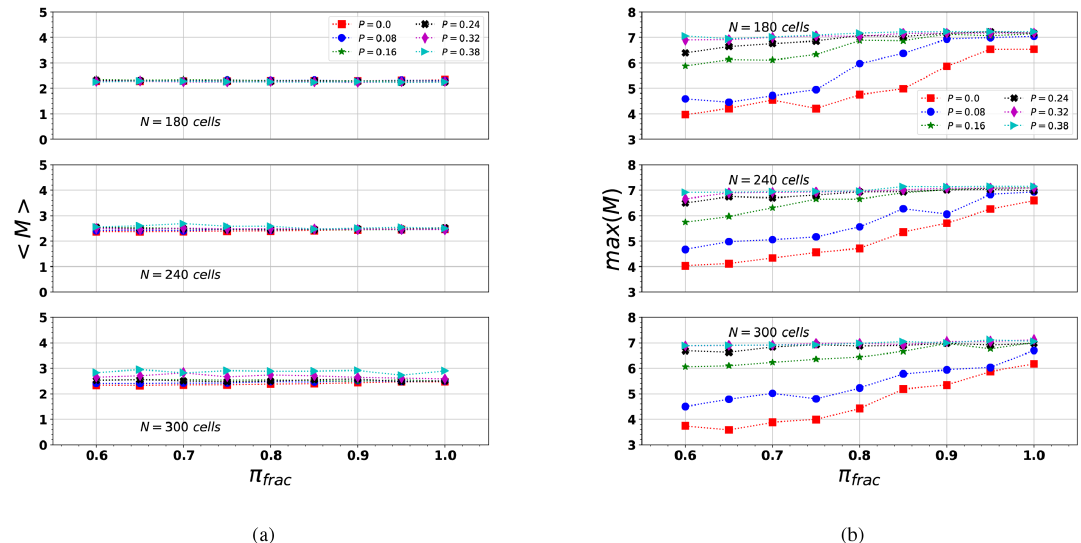
Figure 7. (a) Mean magnitude ( (cid:104) M (cid:105) ) and (b) maximum magnitude (max (M) ) computed for different synthetic series considering three input parameters ( N , P , π frac ). From top to bottom, N = 180, N = 240, and N = 300 (cells per lateral size in the